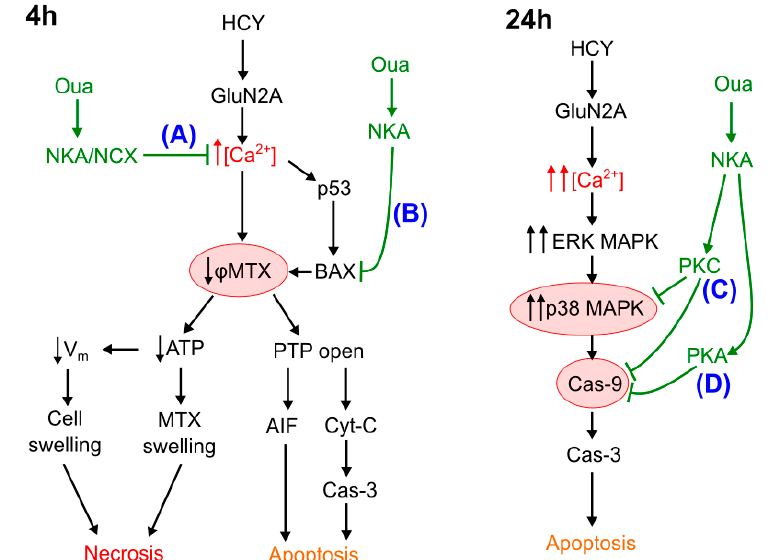
Figure 7. Schematics of data interpretation of antagonism between hyperhomocysteinemia-induced neuronal death and ouabain triggered NKA signaling. The 4 h ouabain effects are kinase-independent and include (A) acceleration of Ca 2+ removal from the cell by NCX, and (B) prevention of Bax translocation to mitochondria. Both (A) and (B) prevent severe ionic imbalance in neurons and augment downstream necrotic and apoptotic neuronal death. The 24 h ouabain effects additionally involve PKC- (C) and PKA-dependent (D) inhibition of HCY-specific ERK/p38 MAPK apoptotic pathways. [Ca 2+ ]—free intracellular calcium concentration; AIF—apoptosis inducing